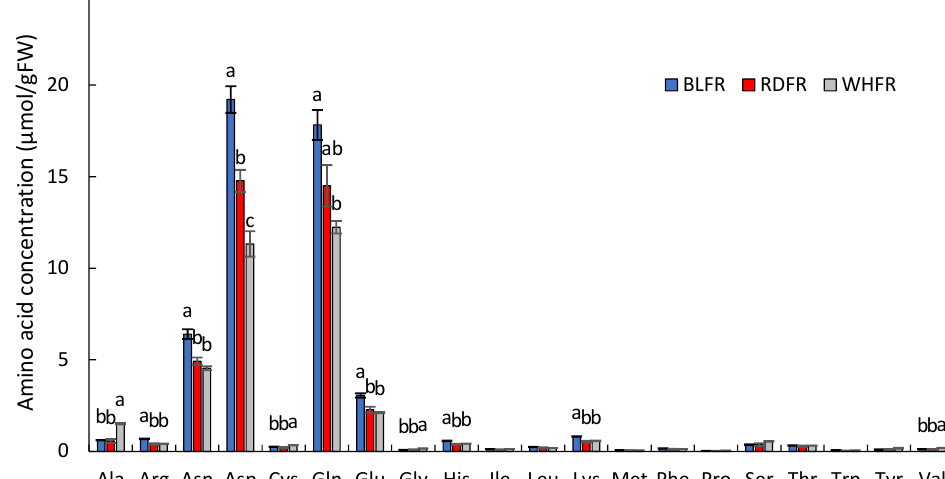
Figure 3. Amino acid concentration in fruits with different light treatments. Values indicate the mean ± standard error (SE; n = 3). Different letters indicate significant differences at p < 0.05 by Tukey’s test. BLFR, RDFR, and WHFR refer to blue, red, and white light-treated fruits, respectively. In this study, the accumulation of two vitamins, ascorbic acid and tocopherol, in fruits was also influenced by light quality. Tocopherol concentration improved in